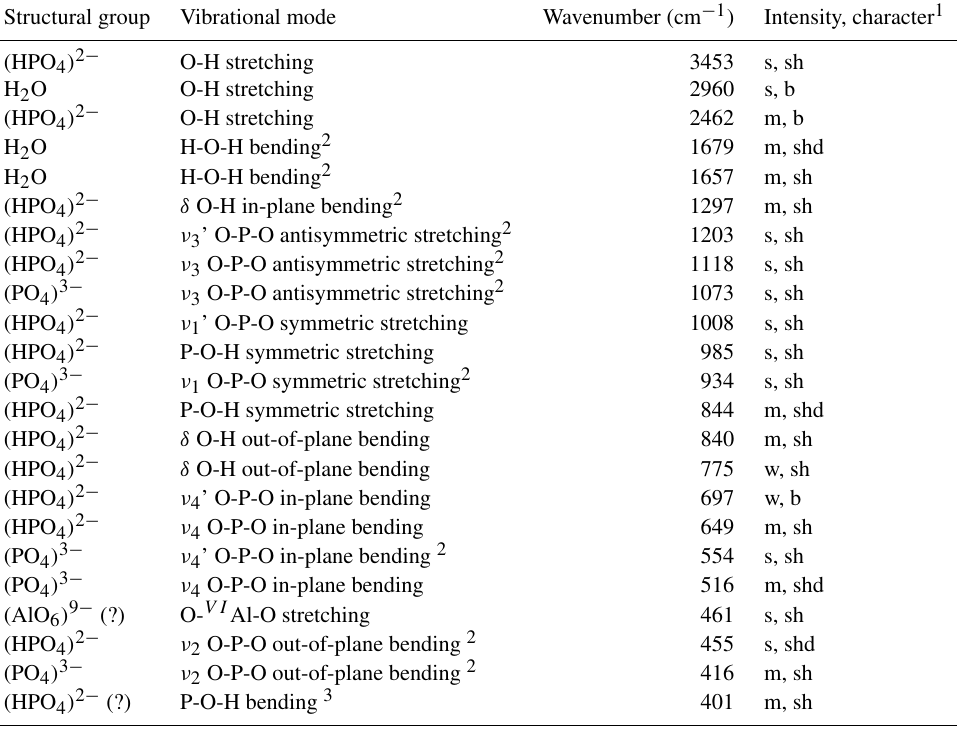
Table 2. Positions and assumptions of the infrared absorption bands recorded for francoanellite from Gura Dobrogei. Structural group Vibrational mode Wavenumber (cm − 1